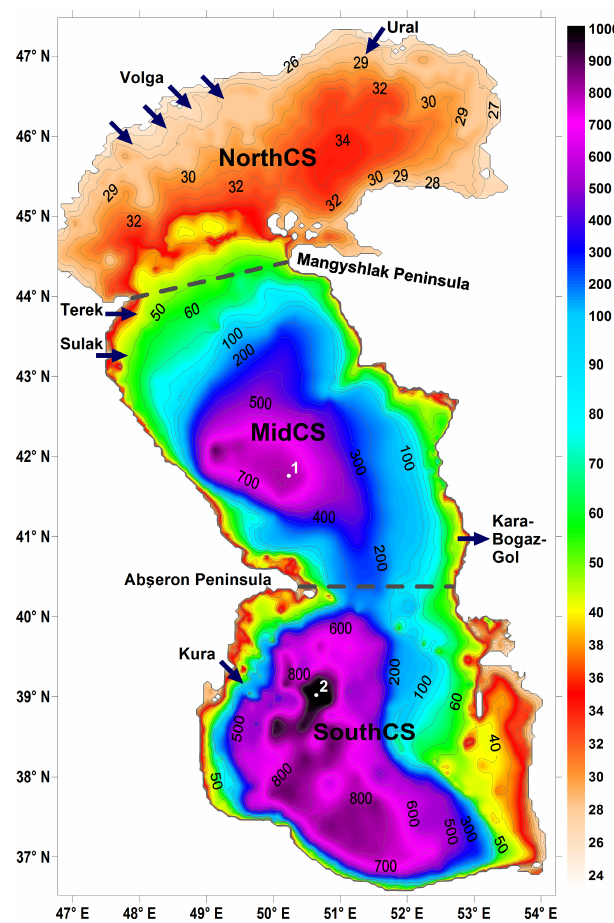
Figure 1. Caspian Sea bathymetry used in the model (depths rela- tive to mean sea level, in meters). The average sea surface height and model vertical grid origin are 28m. Dashed lines indicate conven- tional separation of the sea into three basins: northern (NorthCS), middle (MidCS) and southern Caspian (SouthCS). Arrows desig- nate water inflows due to rivers accounted for in the model and the seawater outflow into the Kara-Bogaz-Gol Bay. Numbers 1 and 2 indicate locations of the deepwater stations from Tuzhilkin and Kosarev (2004), for which reference observational T and S data will be given.